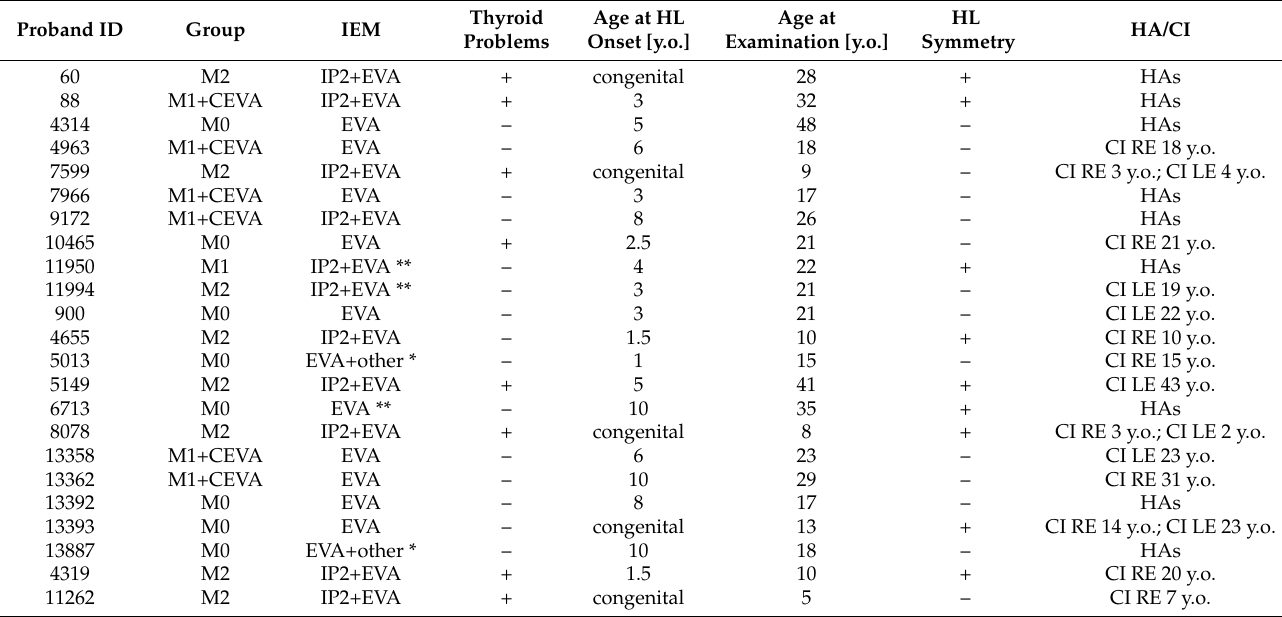
Table 1. Clinical data of tested patients and their assignment to groups based on the SLC26A4